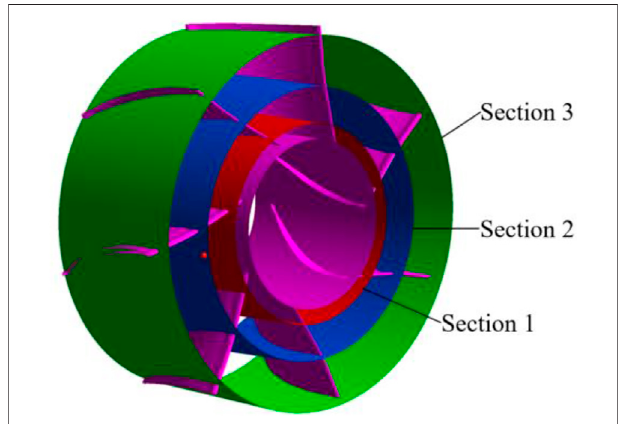
FIGURE 14 | Section diagram of guide vane with different radii.